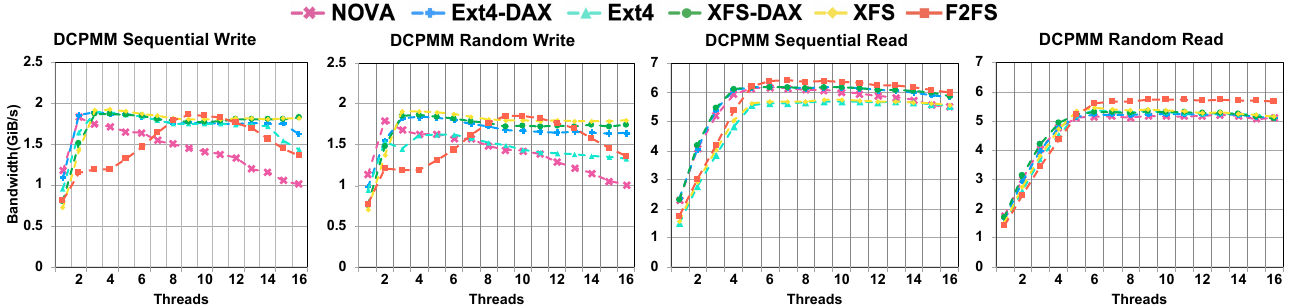
Figure 3. The read/write performance of traditional and NVM-aware file systems on Optane DCPMM when using direct